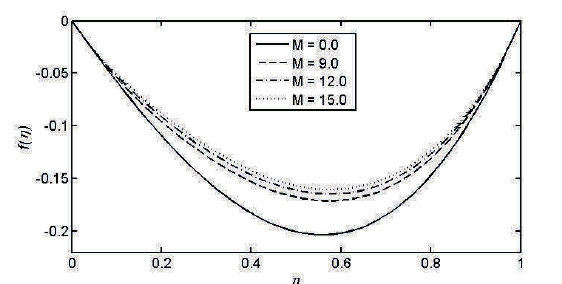
Fig. 4: Variation of f ( η ) for different values of M for λ 1 = 0.5 and λ 1 = 0.2.